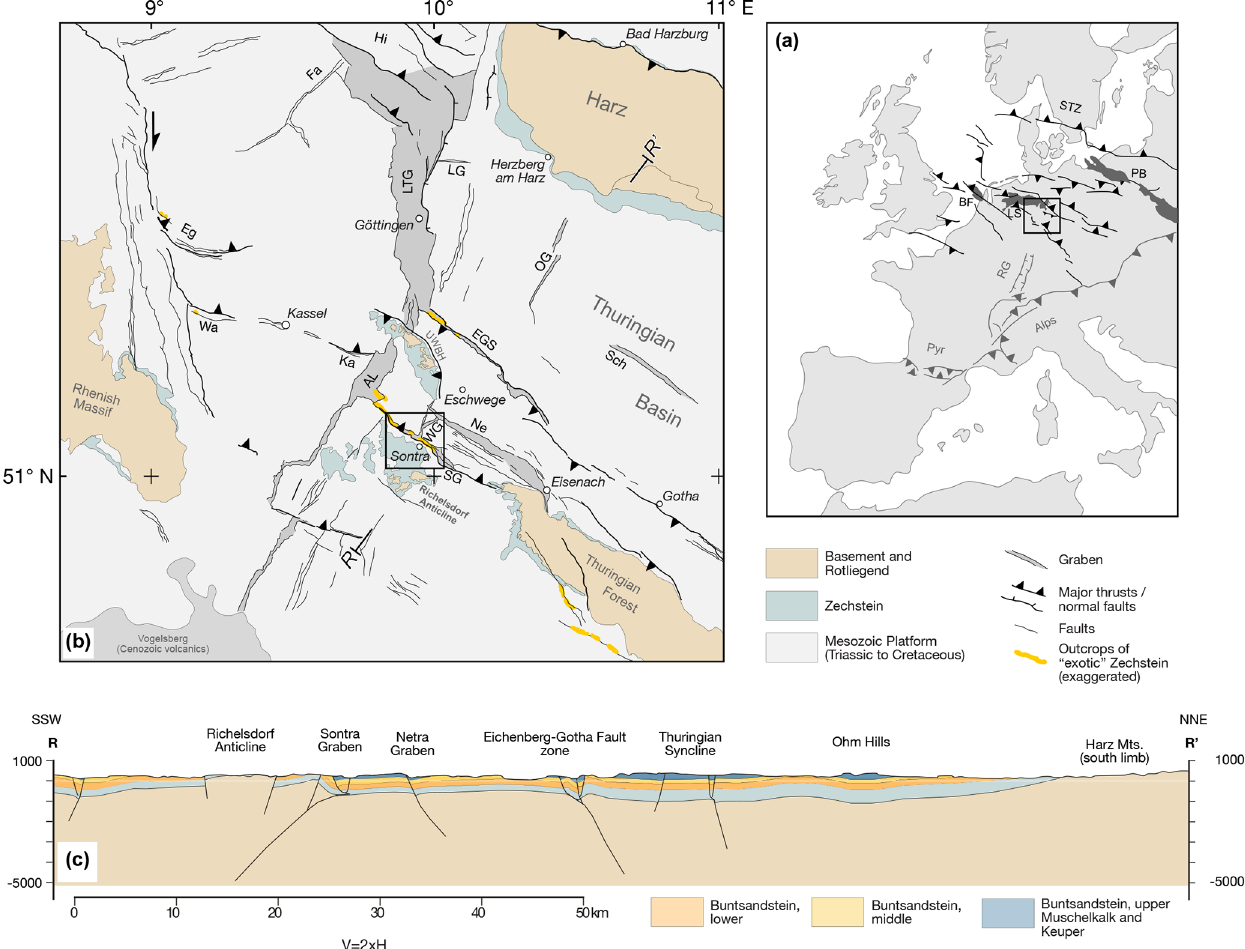
Figure 1. (a) Overview of the Central European Basin System (CEBS). The black box indicates the extent of (b) . (b) Basin architecture of the southern extent of the CEBS. Modified from Kley (2013) and the sources indicated therein. The black box indicates the study area, shown in greater detail in Fig. 4. (c) Regional cross section showing the main basement structures and the relation to the overlying sedimentary cover in the area. Section trace (R–R (cid:48) ) is shown in (b) . Abbreviations are as follows. AL: Altmorschen Lichtenau Graben, BF: